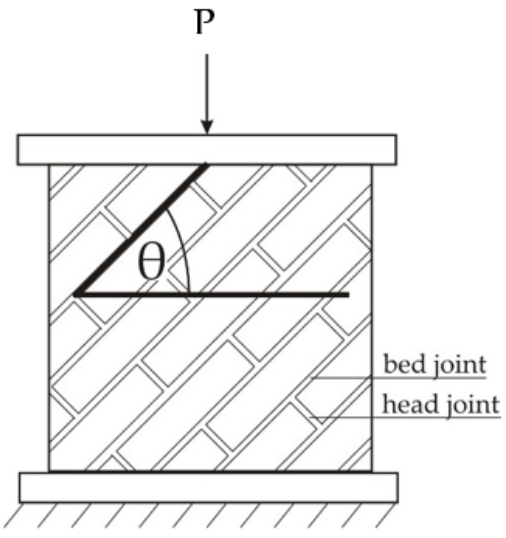
Figure 4. Description of θ angle measurements of tested samples.